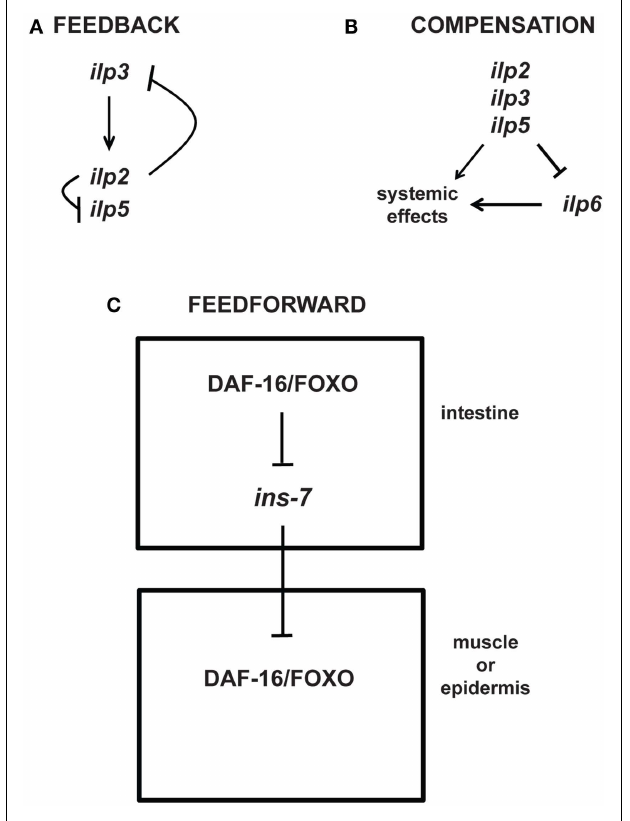
FIGURE 4 | Feedback, compensatory, and feed-forward mechanisms in the longevity-modulating insulin signaling pathway . (A) Neuronally produced Drosophila insulin-like peptides exhibit feedback regulation among each other (Broughton et al., 2008; Grönke et al., 2010). (B) The systemic activities of the Drosophila neuronal ilp2 , ilp3 , and ilp5 can be compensated by the systemic activity of the ilp6 produced from the head fat body (Grönke et al., 2010). (C) C. elegans ILP signaling between tissues (i.e., intestine to muscle or epidermis) involves feed-forward regulation via transcriptional inhibition of the ILP ins-7 (Murphy et al.,